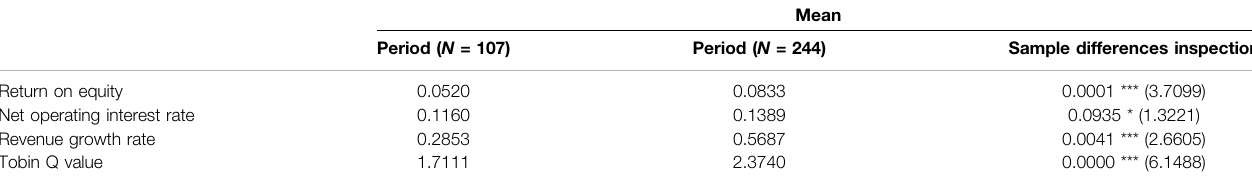
TABLE 13 | Comparison of enterprise capability of venture capital institutions after the late and early intervention.